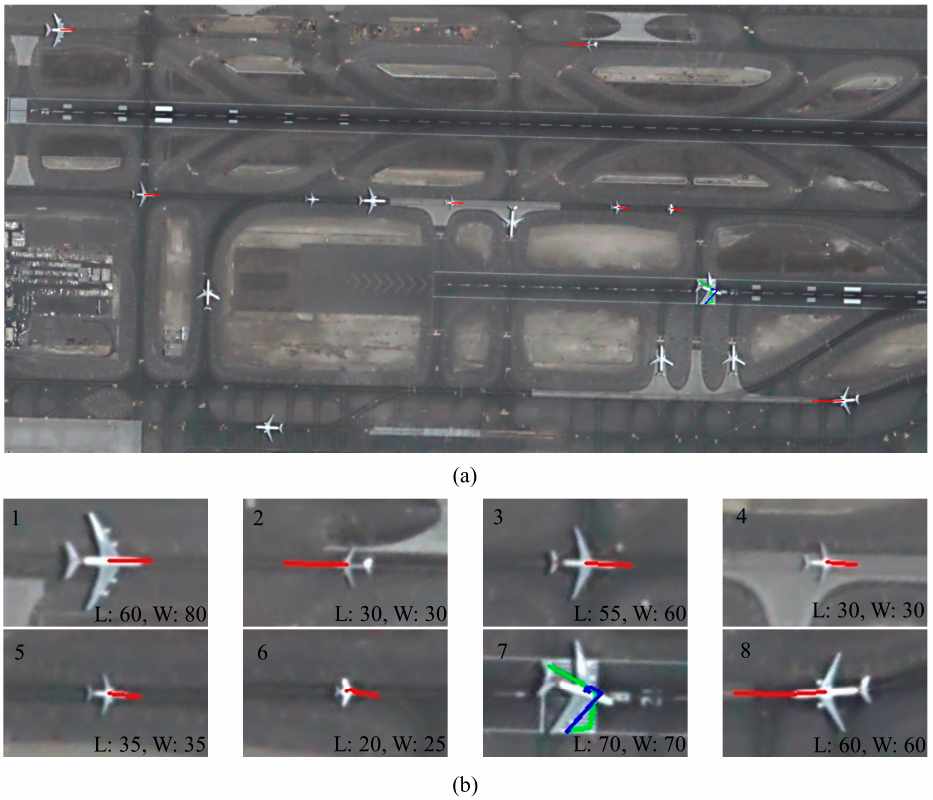
Figure 8. Airplane trajectories estimated from the 150th frame to the last (250th frame): ( a ) trajectories of eight moving airplanes delineated on the true-color 150th video frame, and ( b ) zoomed-in view for each trajectory. The approximate length (L) and width (W) of each airplane are illustrated in meters. The trajectories of Airplane 1–6 and 8 are presented by red lines, and trajectories of the two parts of Airplane 7 are represented by green and blue lines.